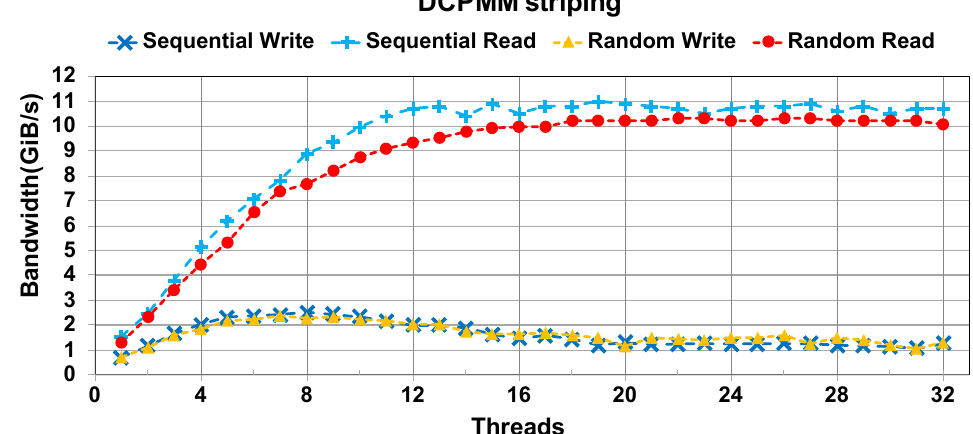
Figure 5. The read and write performance of the Ext4 file system on a dm-stripe DCPMM device that is organized by two DCPMMs sitting in different